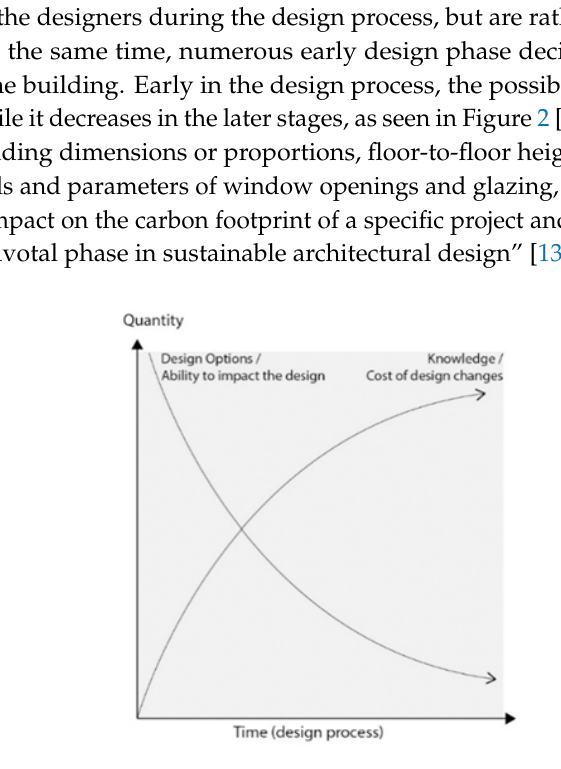
Figure 2. Impact of the information amount on the design process [12].